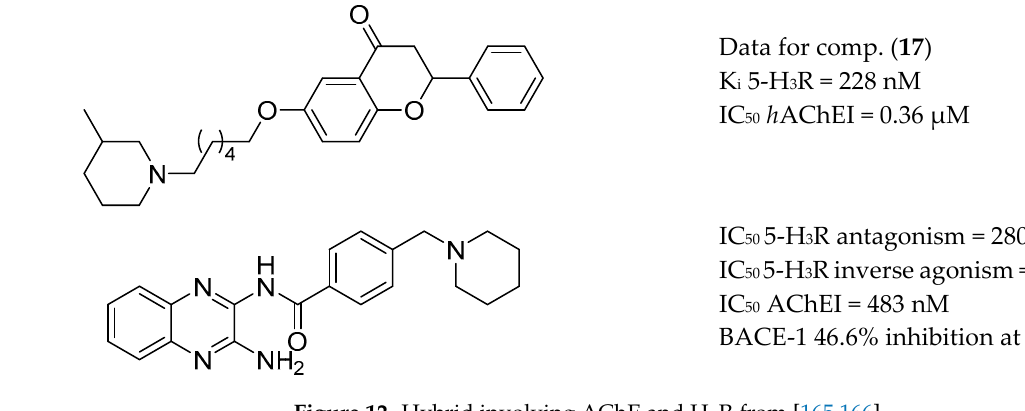
Figure 13. Hybrid of tacrine-clioquinol. In turn, hybrids of tacrine and a flavone, namely coumarin, chromone or donepezil, and curcumin, exhibited a significant ability to inhibit AChE. Additionally, hybrids of tacrine and a flavone, such as coumarin, chromone or donepezil and curcumin, exhibited significant β -amyloid- reducing and metal (Cu 2+ and Fe 2+ ) chelating properties [169–171] (Figure 14).